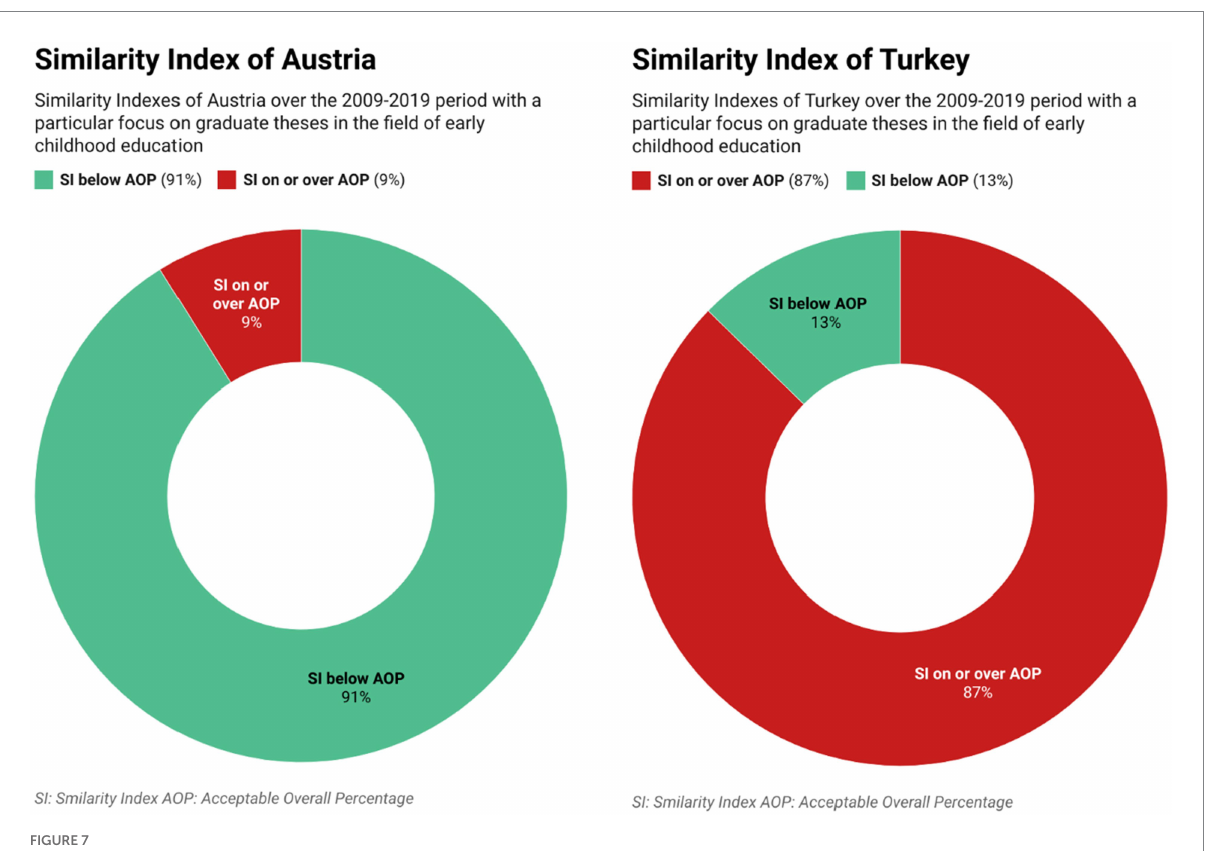
FIGURE 7 Similarity Indexes of Turkey and